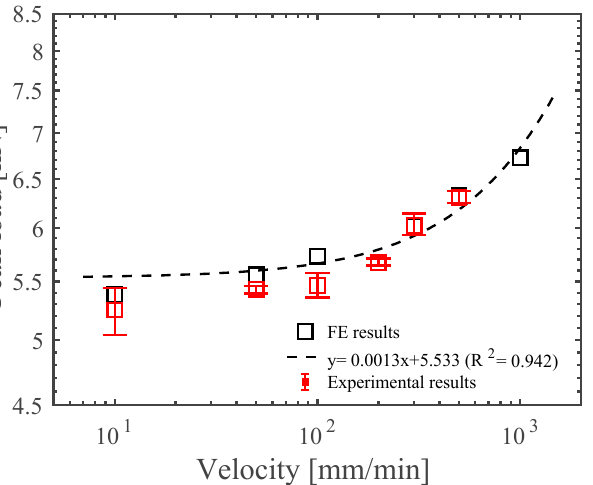
Figure 8. Comparison of the FE results, fitting equation, and experimental results regarding peak load vs. velocity.